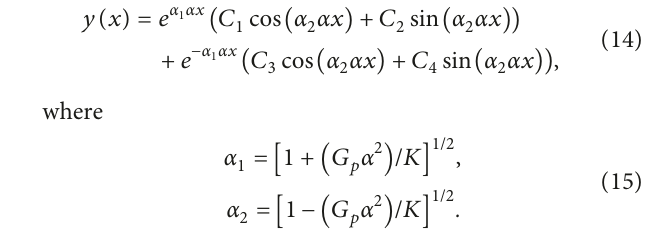
Figure 7: Mechanical model of the feet-lock pipe based on the Pasternak double-parameter foundation.